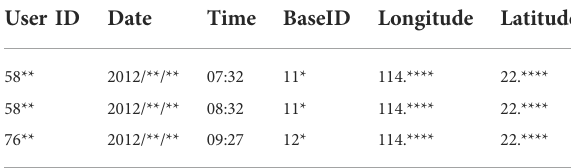
TABLE 1 Sample records of mobile phone location